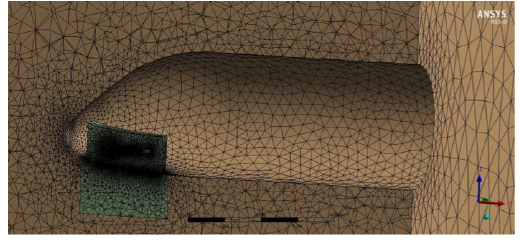
Figure 5. Computational sub-domains with active dynamic meshing.